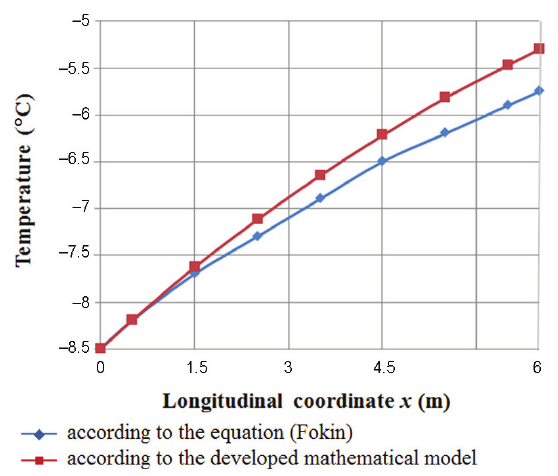
Fig. 4. Comparison of air temperature in the attic space (winter)